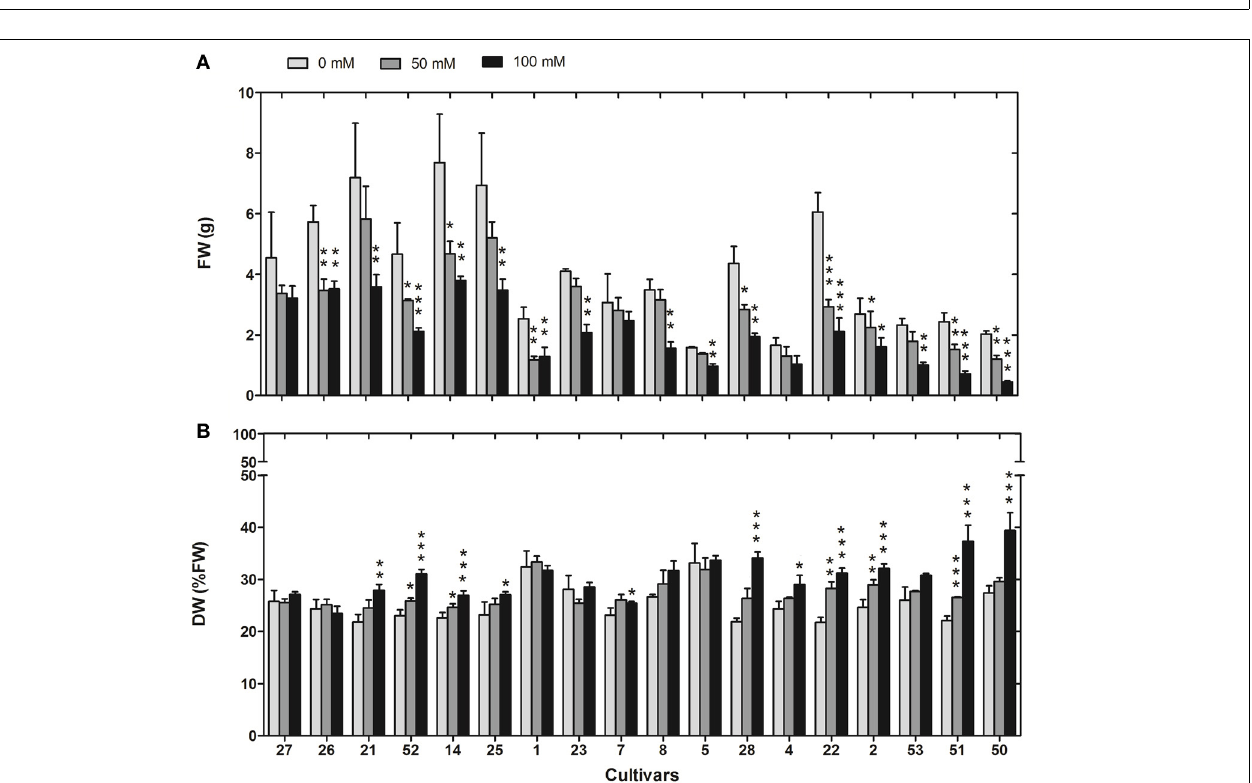
standard errors. Significance levels are indicated as: p < 0 . 001 ( ∗∗∗ ), 0.001 < p < 0 . 01 ( ∗∗ ), 0.01 < p < 0 . 05 ( ∗ ) in comparison to control. Cultivars are sorted from the most tolerant to the most sensitive from left to right.